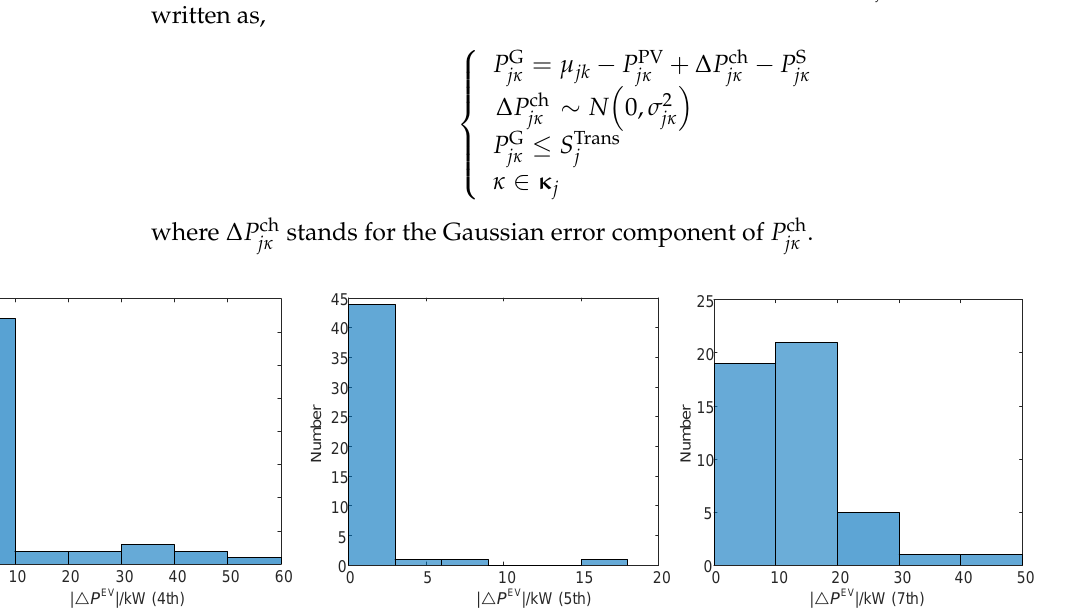
Figure 3. Histograms of EV charging load changes at 4th, 5th, and 7th time intervals in a day.